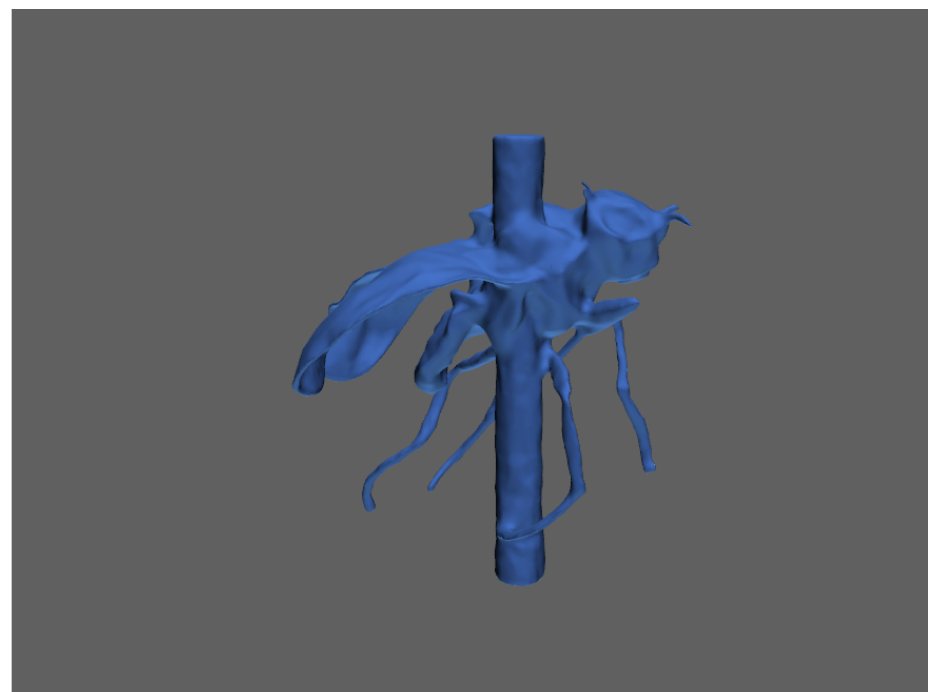
Figure 13. Interactive 3D-model of Oscinella frit (1.5 mm body